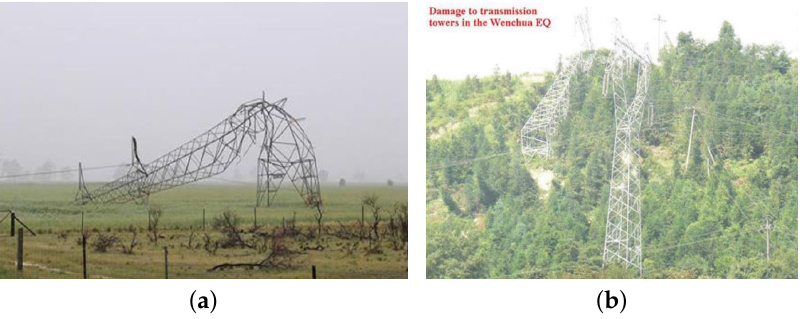
Figure 1. Potential failures in power transmission towers [2,3]. ( a ) Wind-induced failure; ( b ) Earthquake- induced failure